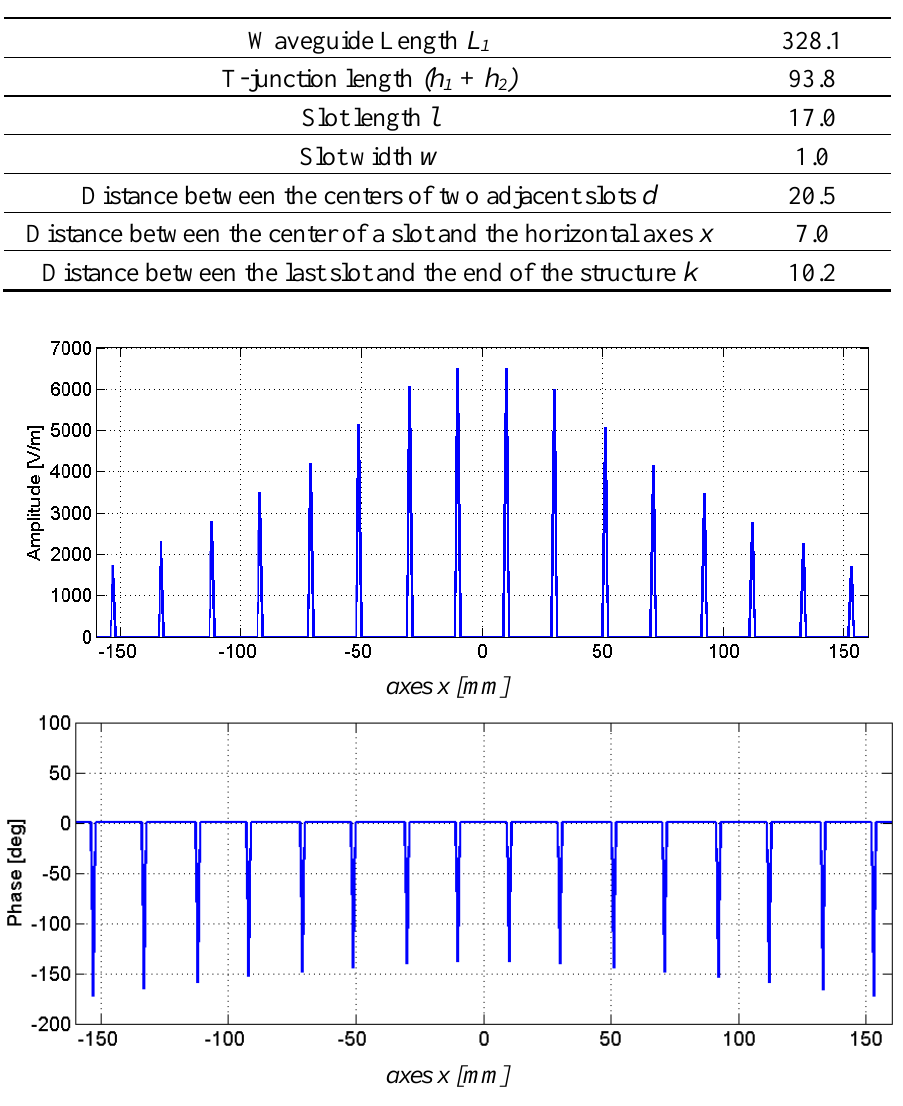
Figure 3. Main geometrical parameters of the transmitting antenna. Table 1. Dimensions (mm) of Geometrical Parameters of the Transmitting Antenna.